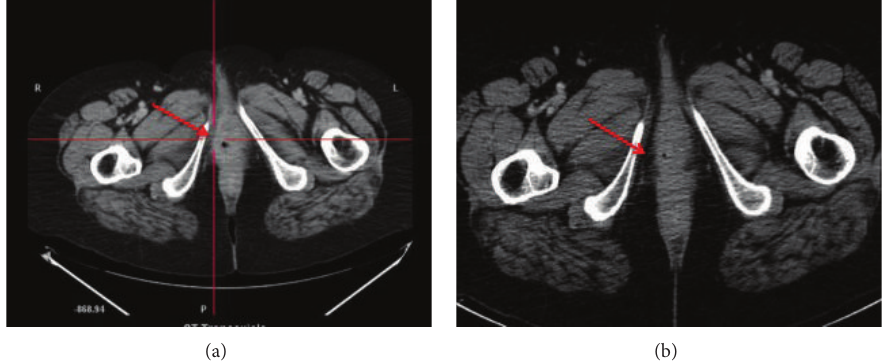
Figure 1: TC images of vulvar cancer lesion before (a) and after (b) neoadjuvant